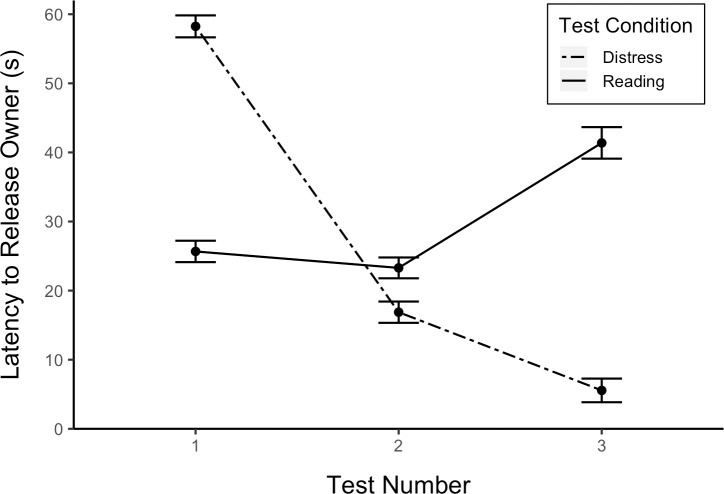
Latency to release the owner by test condition and number (among dogs that successfully opened in the food test).Latency means and standard errors displayed here are back-transformed from the natural log transformation used in analysis. Error bars show standard errors.